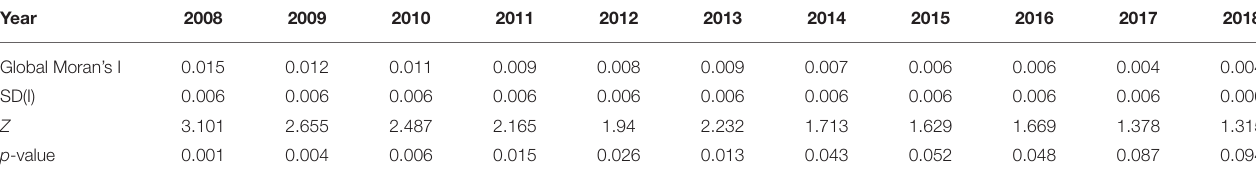
TABLE 5 | Global Moran index of explained variable (HDRIbed).